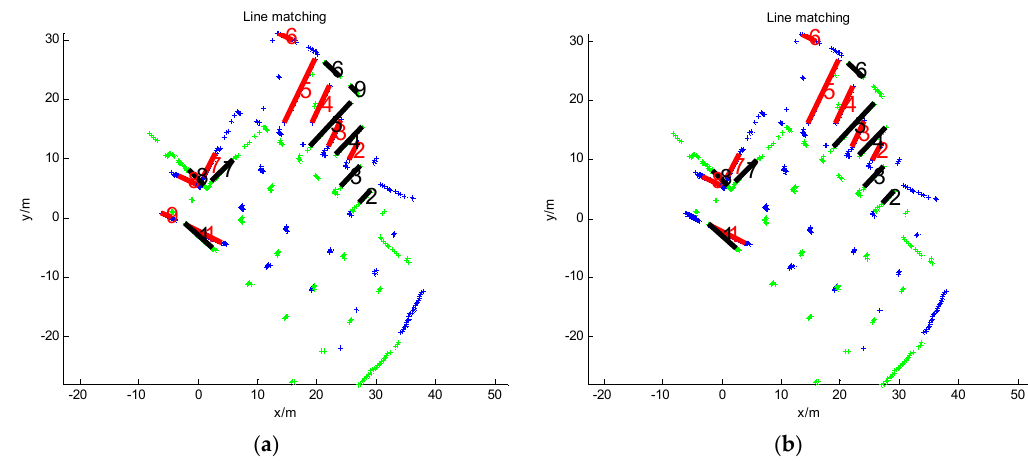
Figure 4. Feature line matching. ( a ) Line correspondences with outliers; ( b ) line matching result after outlier removal.